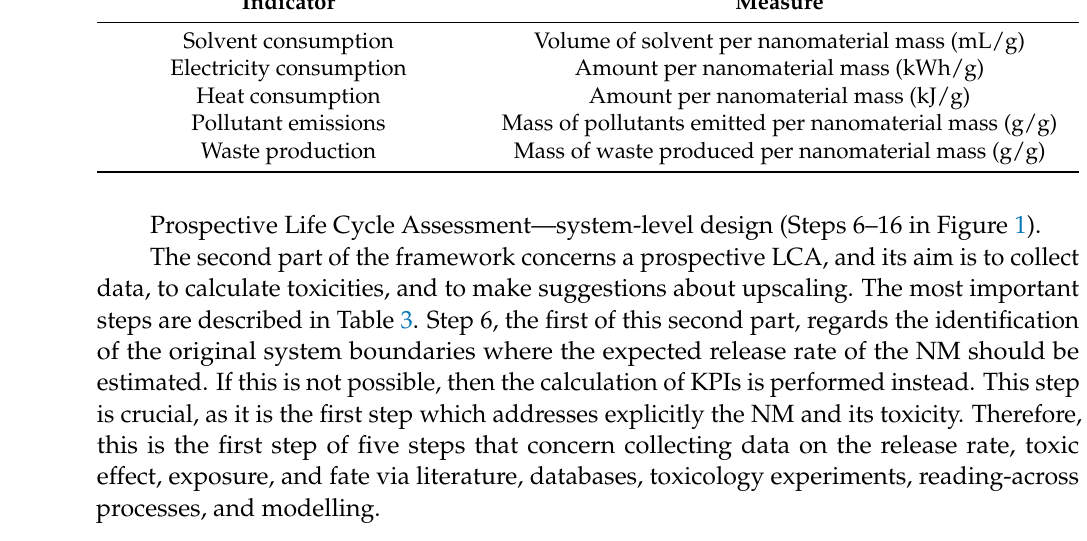
Table 3. Data needed for selected steps of system-level design of